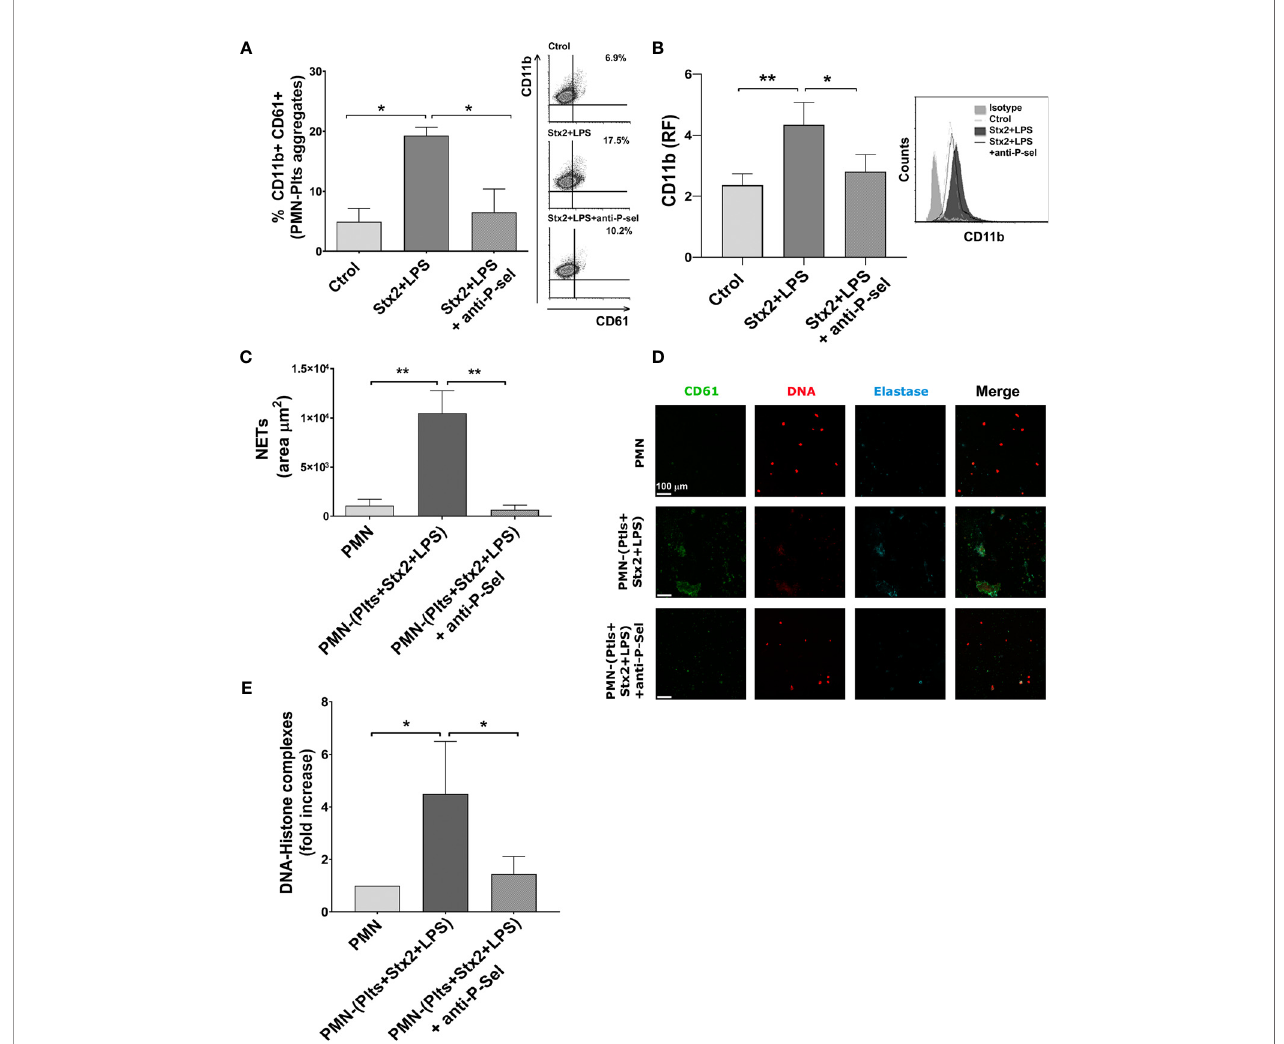
FIGURE 4 | P-selectin blockade reduces mixed PMN – Plts aggregates formation, PMN activation, and netosis. Treated Plts were washed and then co-incubated with PMN in a 1:50 PMN/Plts ratio for 10 min (A) , 40 min (B) , and 6 h (C – E) in the presence or absence of an anti-P-selectin antibody. (A) The percentage of PMN – Plts mixed aggregates formation was determined by fl ow cytometry as the percentage of CD61+ Plts within the gate of CD11b+ PMN (% CD11b+ CD61+). Representative analysis of an independent experiment showing density plots is shown (right) (n=3). (B) CD11b expression on PMN was measured by fl ow cytometry and is shown as the median fl uorescence relative to isotype control (RF). Histogram plots from one representative experiment are presented (right) (n = 6). (C) Area of NETs (µm 2 ) was determined by fl uorescence microscopy, labeling DNA with propidium iodide (PI), neutrophil elastase content with an anti-elastase antibody, and Plts with an anti-FITC- CD61 antibody (n = 7). (D) Micrographs from one representative independent experiment. (E) Fold increase absorbance relative to unstimulated PMN of DNA – histone complexes determined by ELISA after releasing NETs onto supernatants by DNase controlled digestion (n = 3) (mean ± SEM). *p < 0.05; **p <